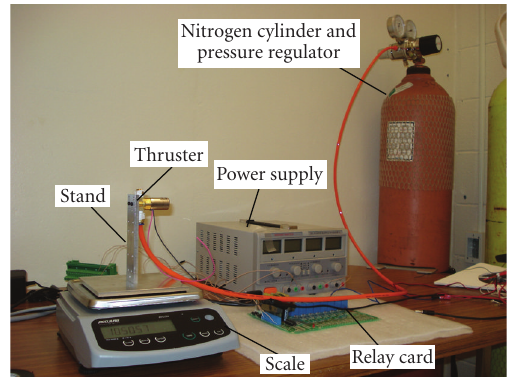
Figure 7: Thruster test system. Table 3: Fuzzy output membership functions.